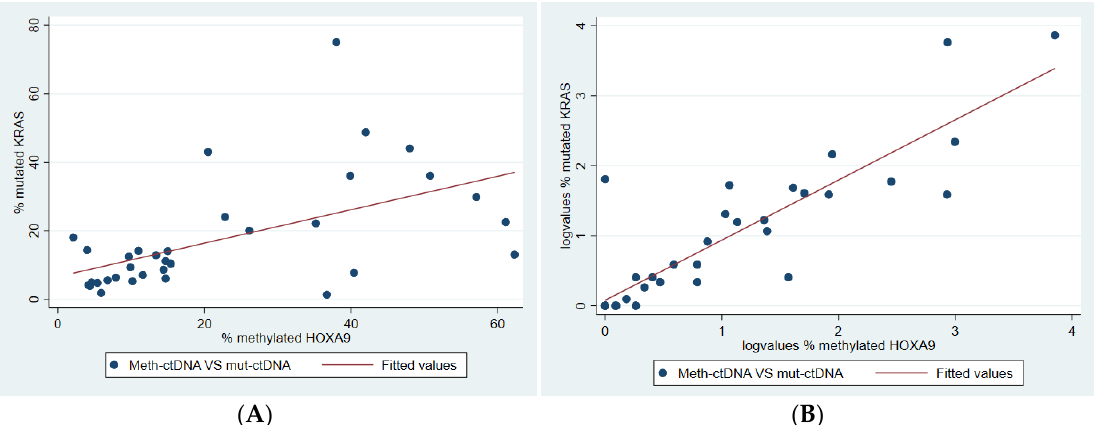
Figure 3. Correlation between methylated Homeobox A9 (meth-HOXA9) and mutated Kirsten rat sarcoma viral oncogene homolog (mut-KRAS). Two-way scatter plot of ( A ) tumor meth-HOXA9 percentages plotted against mut-KRAS percentages and a trend line and ( B ) plasma meth-HOXA9 percentages plotted against the mut-KRAS percentages (both log-transformed) with a trend line.